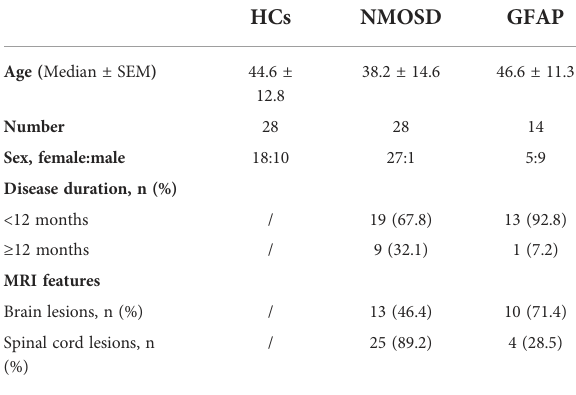
TABLE 1 Clinical information presentation of HCs, NMOSD patients, and GFAP